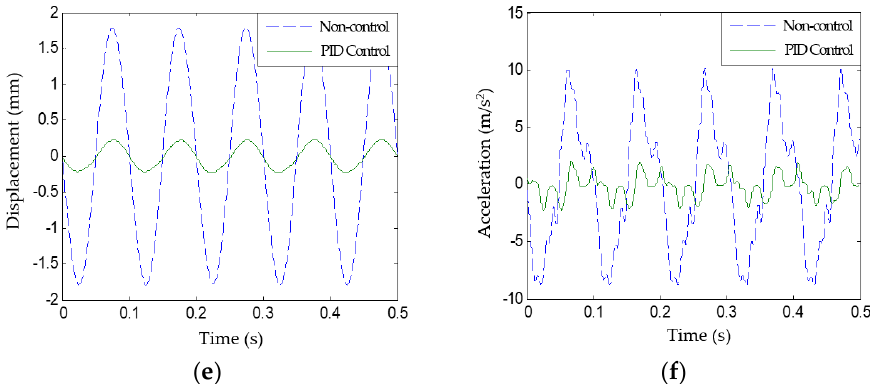
Figure 15. Pipeline vibration response under PID control and excitation frequency of 1, 5, 10 Hz: ( a ) Displacement-time curve (1 Hz); ( b ) Acceleration-time curve (1 Hz); ( c ) Displacement-time curve (5 Hz); ( d ) Acceleration-time curve (5 Hz); ( e ) Displacement-time curve (10 Hz); ( f ) Acceleration-time curve (10 Hz). Table 3. Vibration response of pipeline under PID pipeline vibration control.